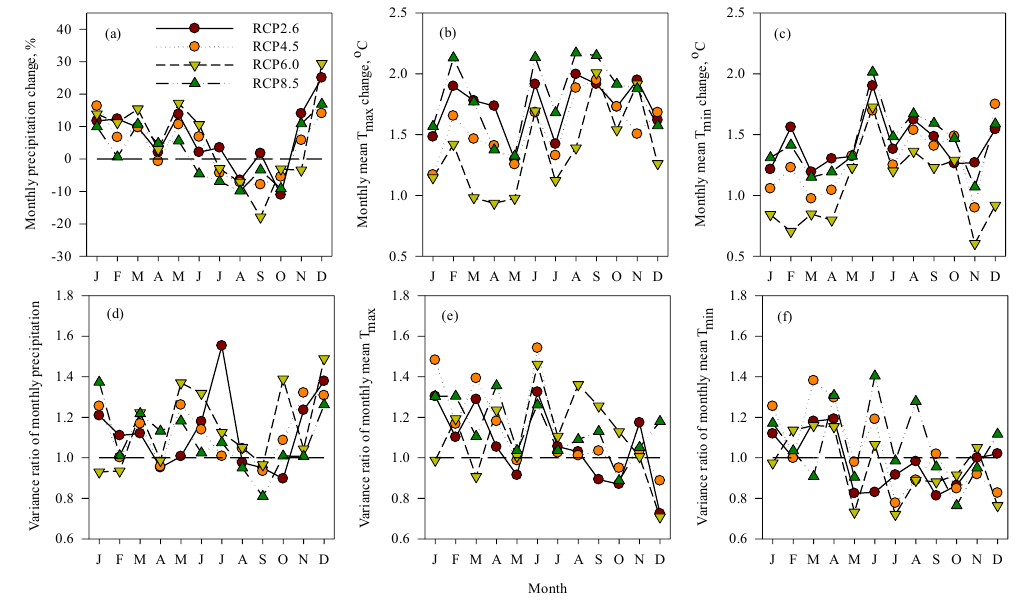
Figure 6. Changes in the averages and variances of monthly climate during 2011–2040 relative to